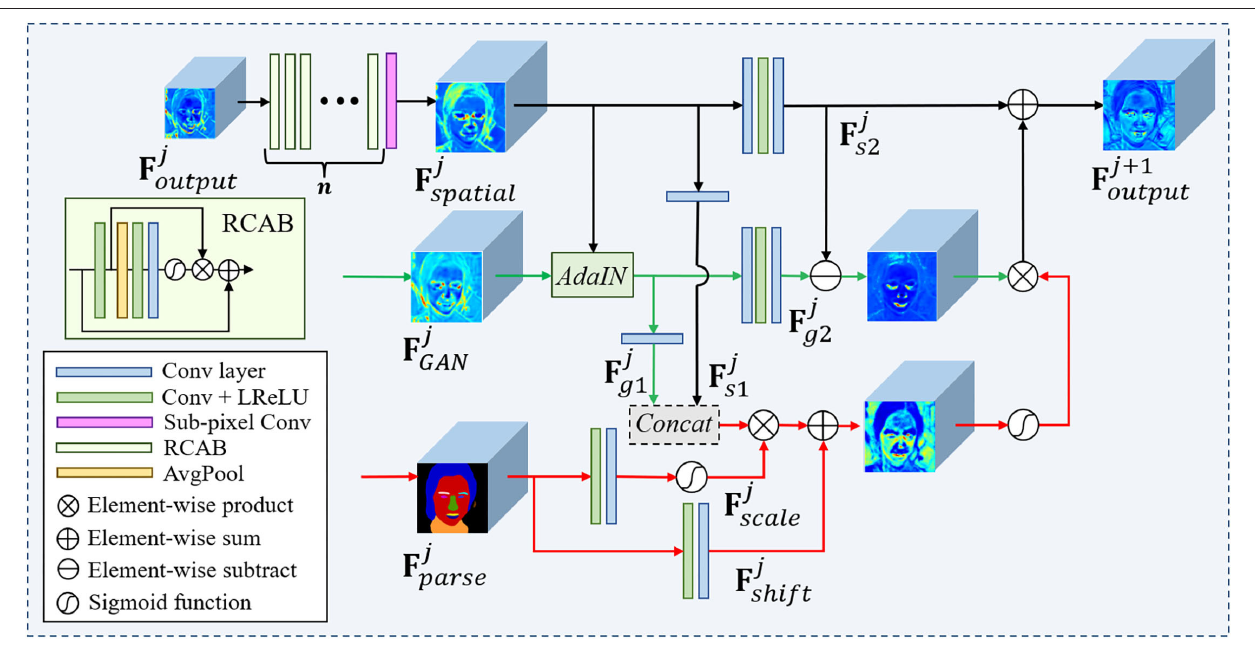
FIGURE 3 | The detailed structures of a GAN block. The definition of “Mod” and “Demod” can be found in Karras et al.